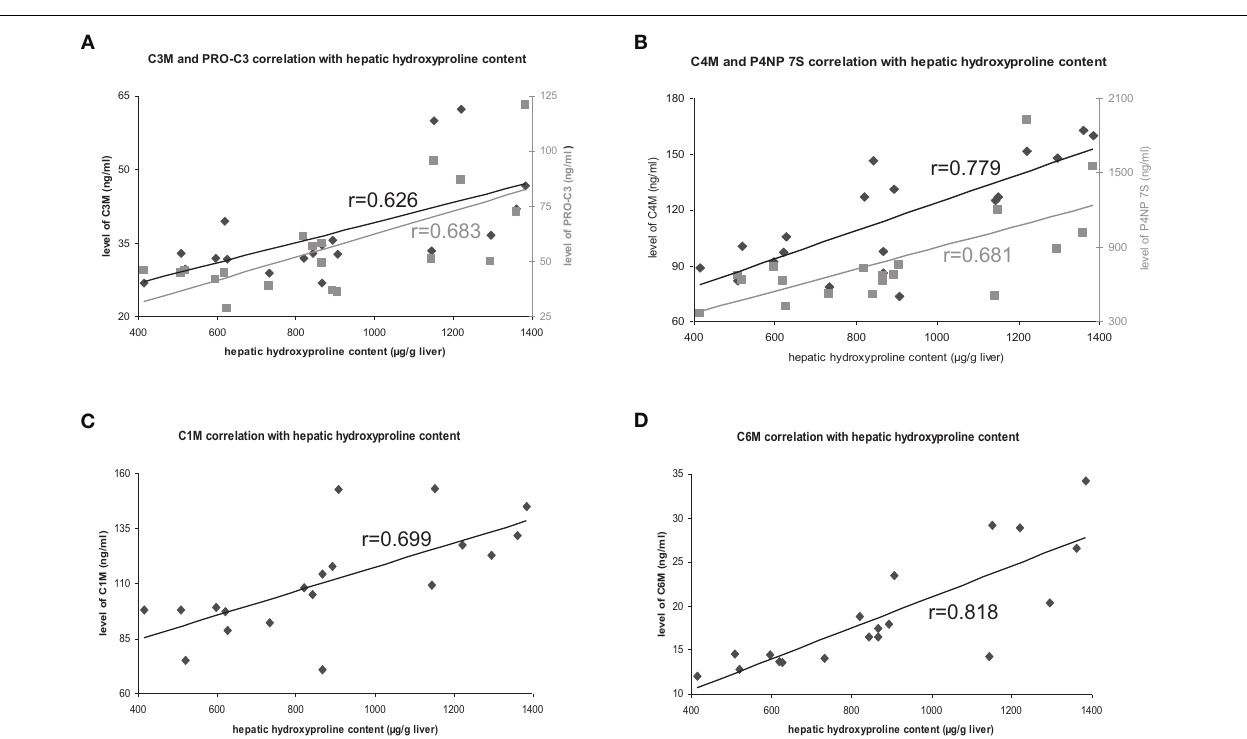
LEVELS OF ECM REMODELING MARKERS IN SERUM OF BDL